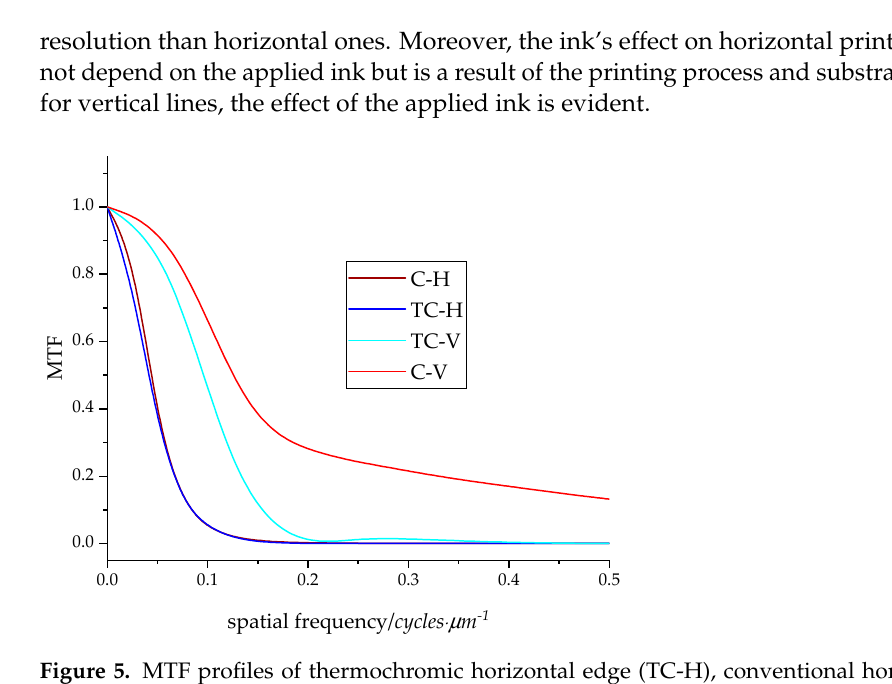
Figure 5. MTF profiles of thermochromic horizontal edge (TC-H), conventional horizontal edge (C-H), thermochromic vertical edge (TC-V), and conventional vertical edge (C-V). Table 4. Spatial frequencies at 50% MTF values and 10% MTF values for thermochromic horizontal edge (TC-H), conventional horizontal edge (C-H), thermochromic vertical edge (TC-V), and con- ventional vertical edge (C-V).